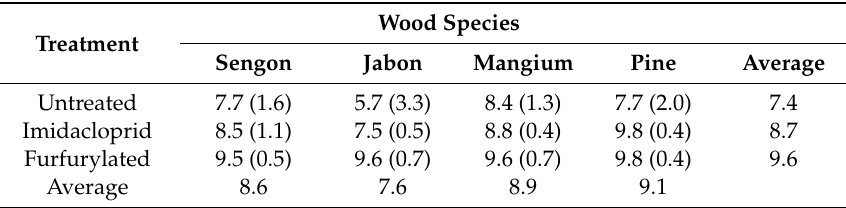
Table 6. Protection level of specimens.